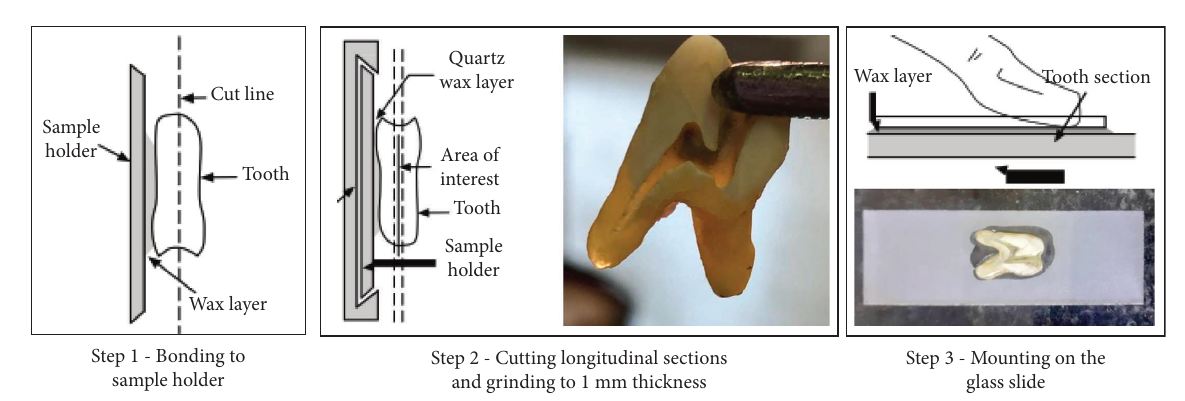
Figure 1: Preparation of tooth sections for SEM